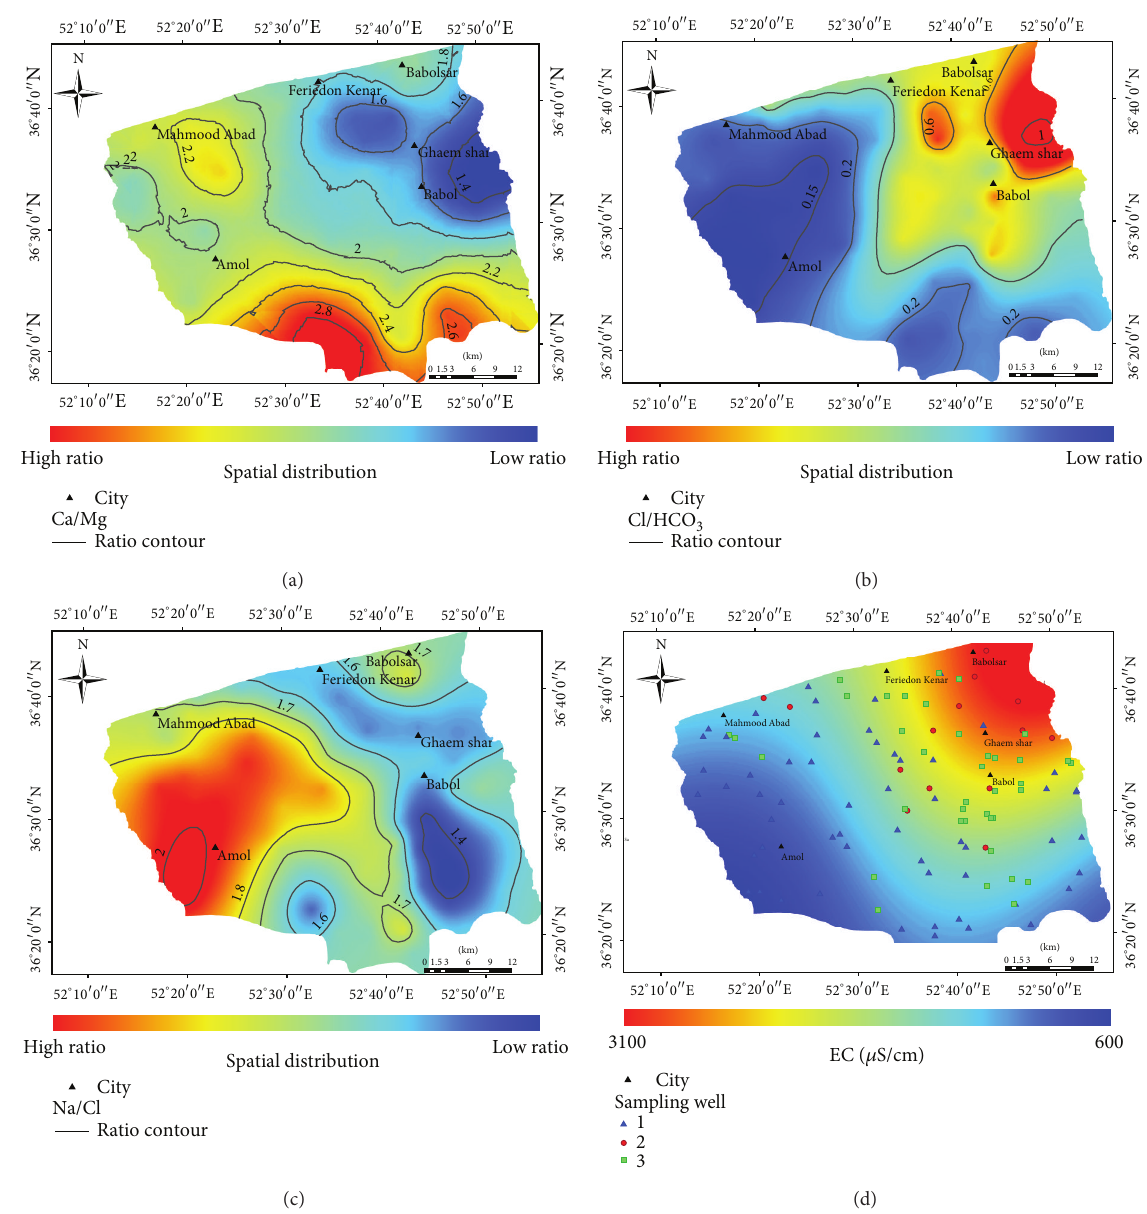
Figure 6: Spatial distribution of (a) Ca/Mg ratio, (b) Cl/HCO 3 ratio, (c) Na/Cl ratio, and (d) electrical conductivity, of groundwater in Amol- Babol